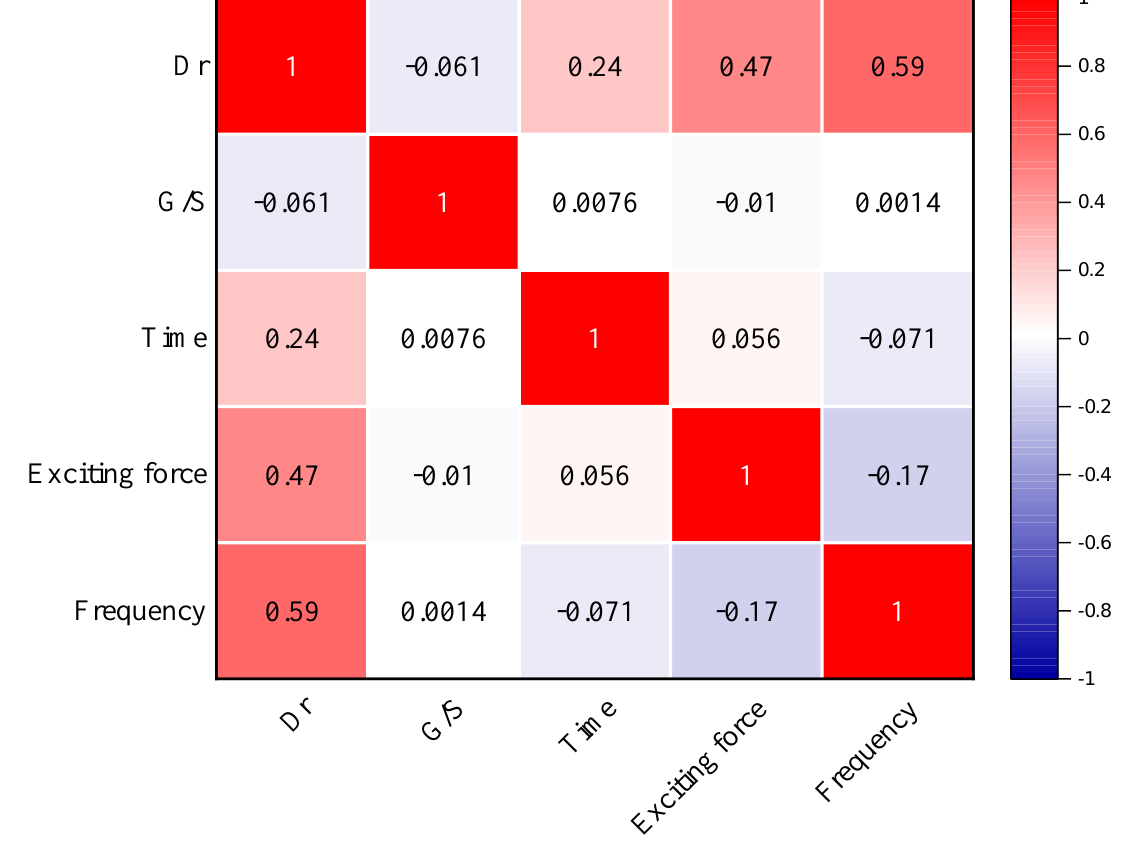
Figure 11. Correlation analysis between variables in plate vibratory compaction test. Table 5. Compaction results of UPAB specimens with G / S = 1.6 from different laboratory com- paction